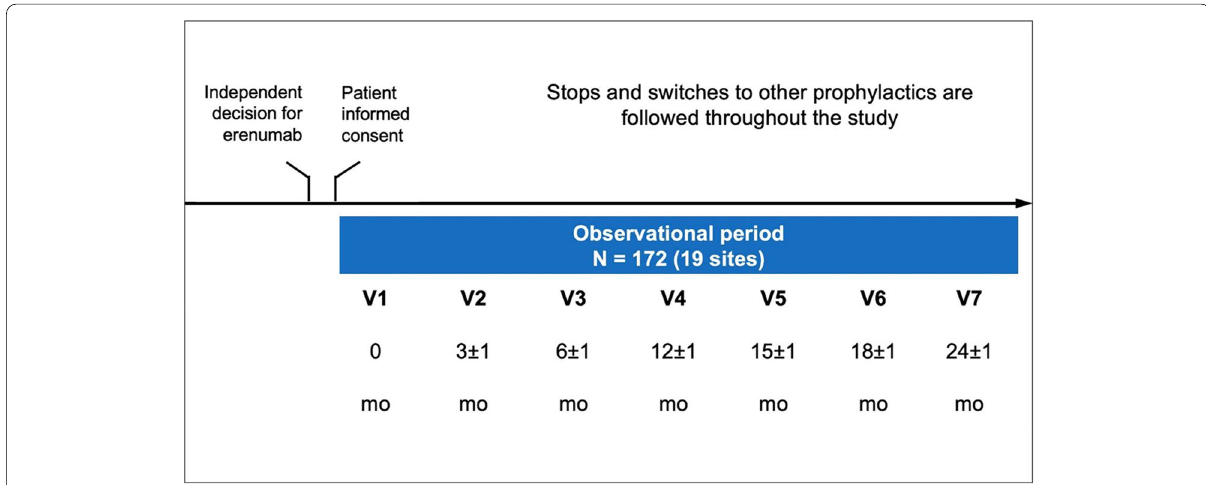
Fig. 1 Study design and visit schedule. mo: month; V: